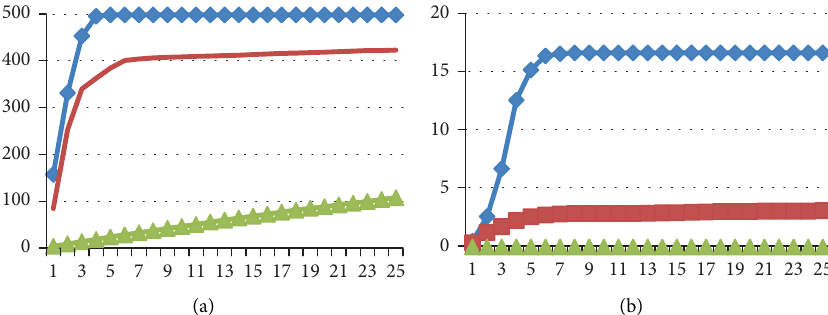
Figure 2: Comparison of the difusion of NEV with diferent numbers of opinion leaders: (a) difusion of information and (b) difusion of products.